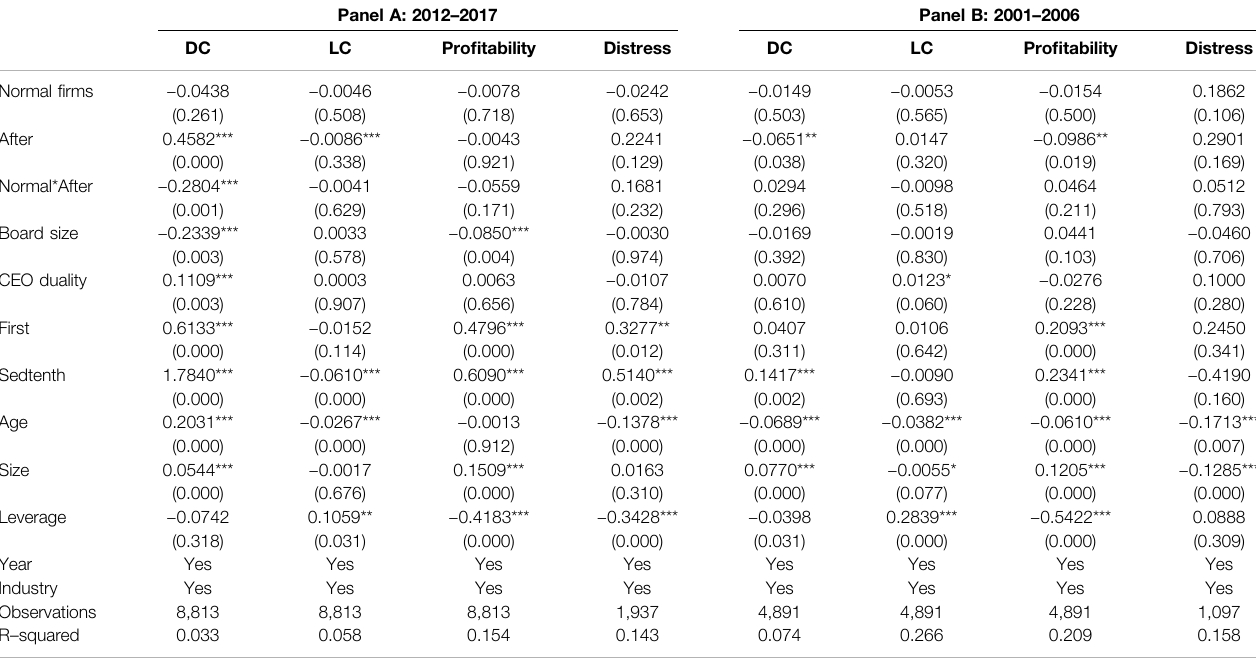
TABLE 9 | Normal fi rm performance. This table presents the results of normal fi rm performance. We de fi ne normal fi rms as those neither belong to heavy polluters nor belong to environmental friendly fi rms.